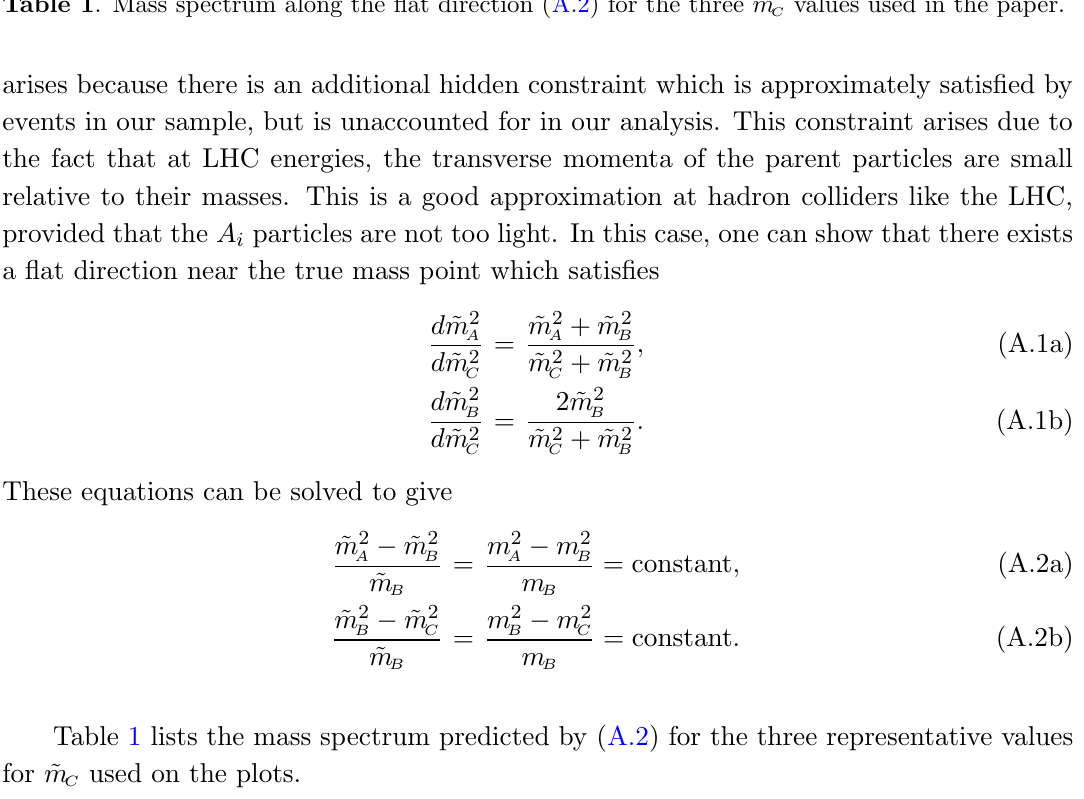
Table 1 . Mass spectrum along the (cid:13)at direction (A.2) for the three ~ m